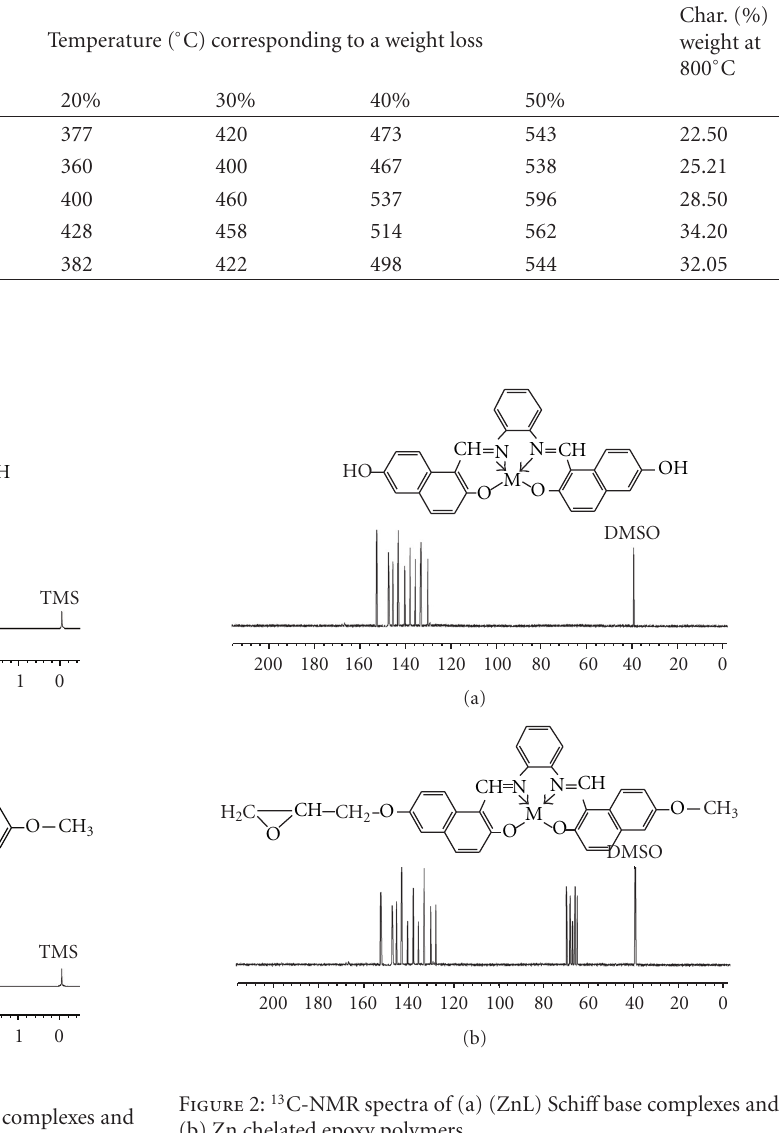
Table 2: Thermal behaviors of metal-chelated epoxy polymers.